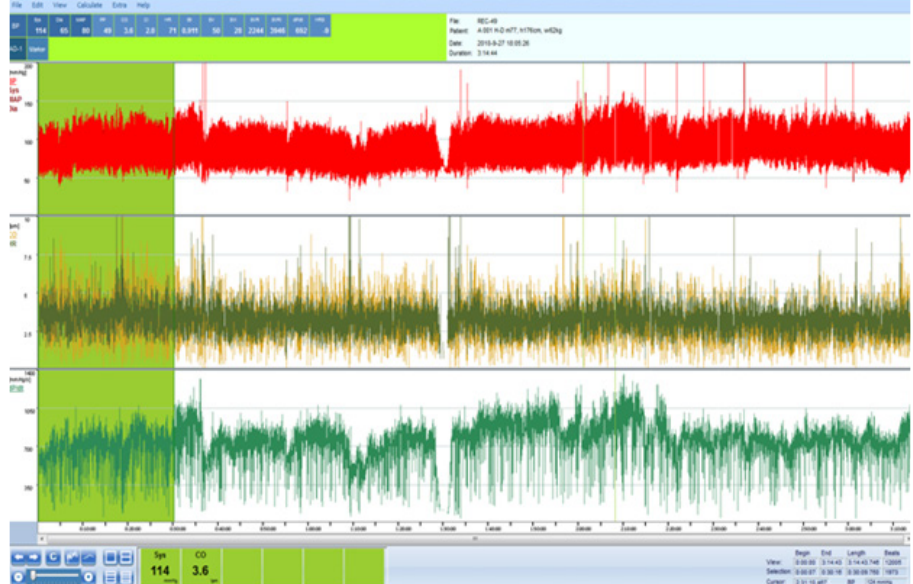
Figure 1. Nexfin continuous hemodynamic recording. Nexfin continuous HD recording in a non-sedated, non-intubated patient showing beat to beat variability. Averaging the first 15 minutes (shaded area) smooths out these